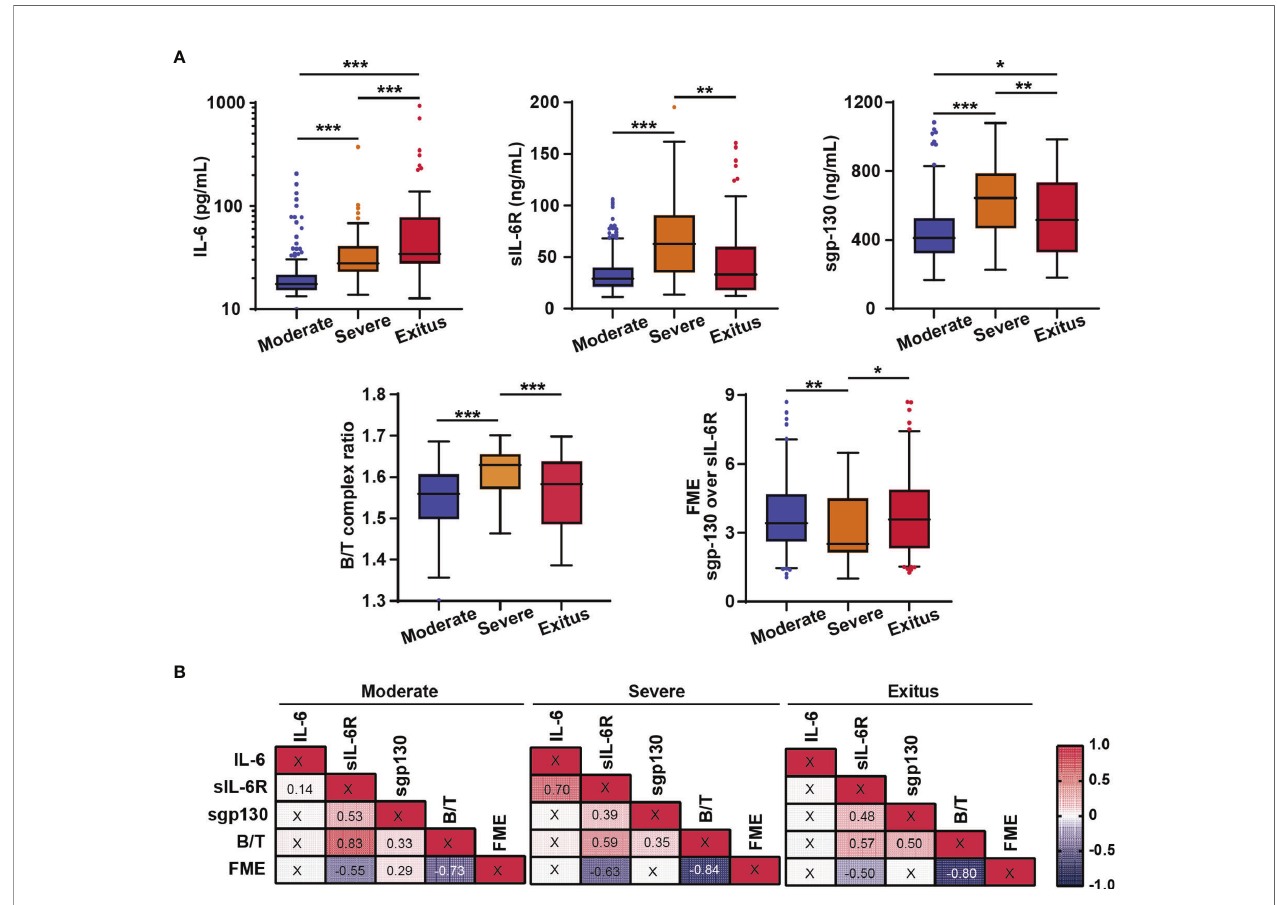
FIGURE 1 | Analysis of IL-6 signalling biomarkers. (A) Serum levels of IL-6, sIL-6R and sgp130, and Binary/Ternary complex ratio (B/T) and fold molar excess of sgp130 over sIL-6R (FME) in moderate (n = 257), severe survivors (n = 40) and severe non-survivors (exitus) (n = 69) hospitalized COVID-19 patients. Box plots showed median with upper and lower quartiles. The whiskers show Tukey con fi dence intervals. (B) Correlation matrix of IL-6 signalling variables assessed using Spearman ’ s Rho analysis. Statistically signi fi cant results are shown with the corresponding correlation coef fi cients. Binary/Ternary complex ratio (B/T); Fold molar excess of sgp130 over sIL-6R (FME). * p < 0.05; ** p < 0.01; *** p < 0.001; “ X ” no statistical signi fi